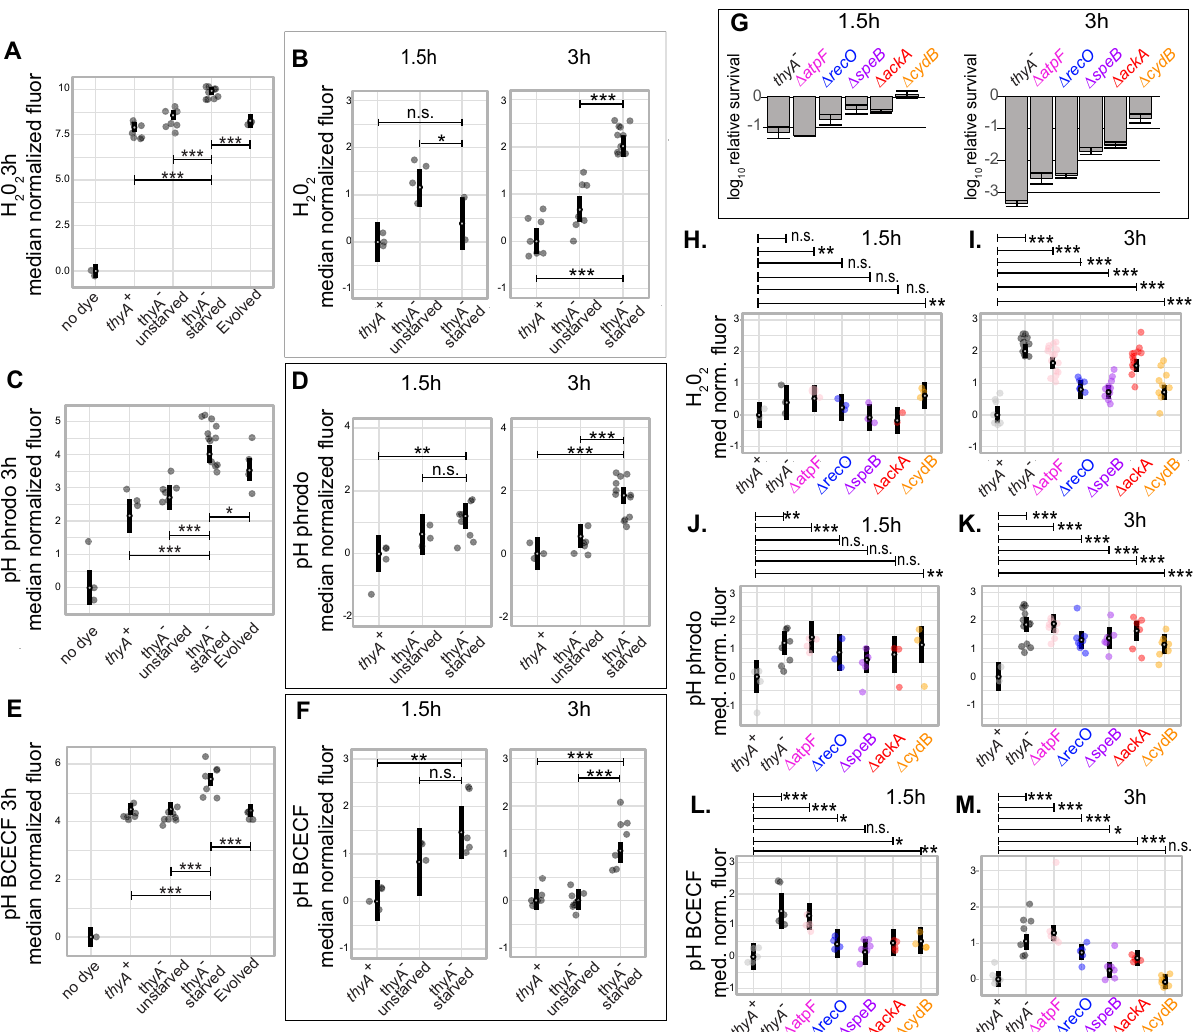
Fig 3. Cells undergoing TLD show intracellular acidification followed by ROS accumulation, with the degree of survival correlated with pH. Fluorescence data after accounting for cell size/shape (see Methods). Fluorescence was measured for each independent experiment using flow cytometry; in all flow cytometry figures unless otherwise noted, the large point for each condition shows the fitted effect for that biological condition, with error bars showing a 95% confidence interval. In addition, the median for each biological replicate is shown as a smaller translucent point (note that the shown biological replicates do not reflect corrections due to the random effect terms of the model, and thus show the actual biological variability of the experiment prior to model regularization). All values are offset by the fitted value for the first condition shown, which is thus centered on zero. Stars show significance tests based on the mixed effects model: � P < 0.05, �� P < 0.01, ��� P < 0.001, ���� P < 0.0001. (A-F) Adjusted fluorescence for thyA + , parental, and evolved strains in the MG1655 background. All strains are in thymidine-free media except for those marked “unstarved”. (A-B) Adjusted fluorescence for strains dyed for H 2 O 2 using Peroxy Orange. (A) Adjusted fluorescence measured at 3h. (B) Adjusted fluorescence measured at 1.5h and 3h. (C-D) Adjusted fluorescence measured for strains dyed for pHi using pHrodo Green. (C) Adjusted fluorescence measured at 3h. (D) Adjusted fluorescence measured at 1.5h and 3h. (E-F) Adjusted fluorescence measured for strains dyed for pHi using BCECF-AM. (E) Adjusted fluorescence measured at 3h. (F) Adjusted fluorescence measured at 1.5h and 3h. (G) Survival of the parental strain and knockouts in the MG1655 background at 1.5h and 3h thymidine starvation. (H-M) All strains shown are in thymidine-free media and in the MG1655 background. (H-I) Adjusted fluorescence for strains stained for H 2 O 2 using Peroxy Orange. (H) Adjusted fluorescence at 1.5h thymidine starvation. (I) Adjusted fluorescence at 3h thymidine starvation. (J-K) Adjusted fluorescence for cells stained for pHi using pHrodo Green. (J) Adjusted fluorescence at 1.5h and (K) Adjusted fluorescence at 3h. (L-M) Adjusted fluorescence for cells stained for pHi using BCECF-AM. (L) Adjusted fluorescence at 1.5h. (M) Adjusted fluorescence at